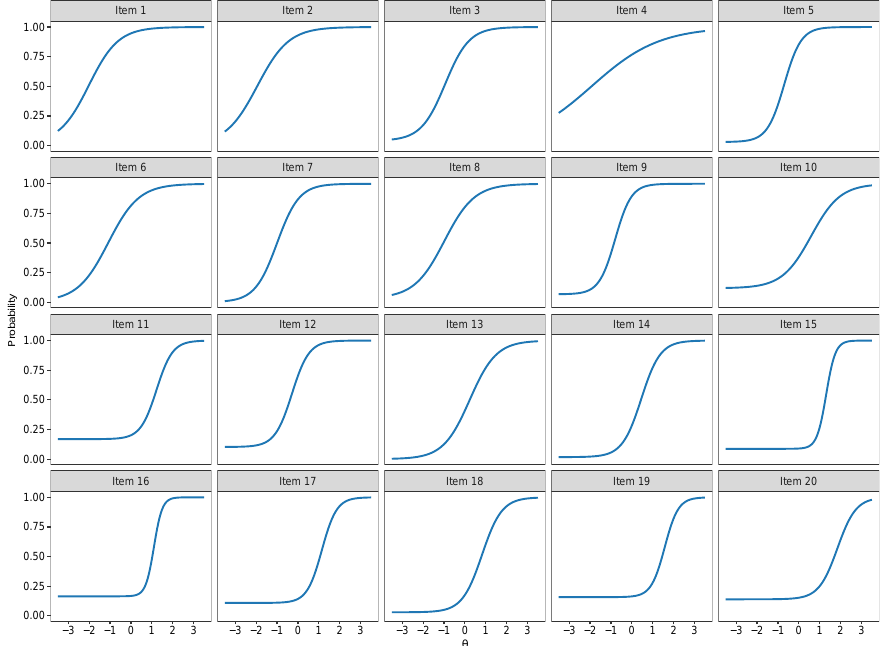
Figure 3. Item characteristic curve plots of the 3-Parameter Logistic